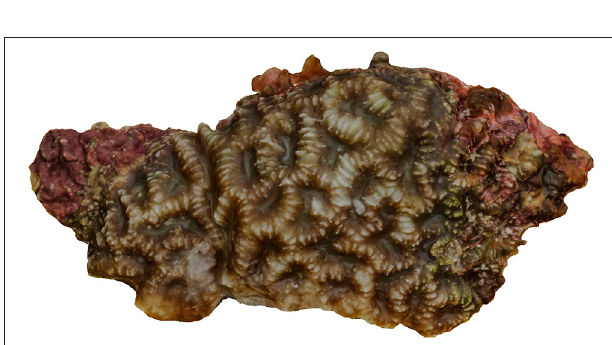
FIGURE 2 | Full colour 3D model of Platygira daedalea colony generated from a fresh sample (Keaveney et al., 2016).